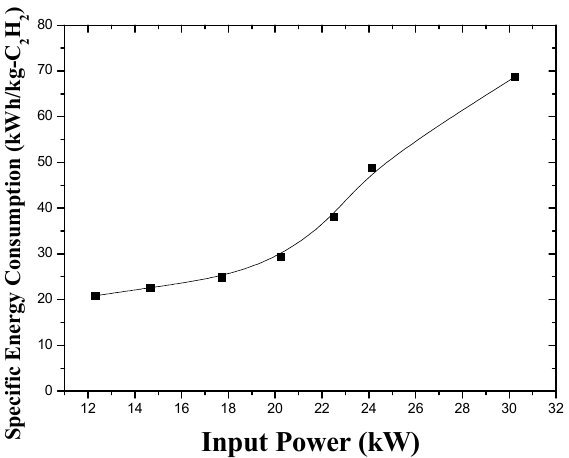
Figure 13. Variation in specific energy consumption of C 2 H 2 with varied input power (Carrier gas flow rate: 1 Nm 3 /h; working gas flow rate: 5 Nm 3 /h; feed rate: 17.65 g/min; magnetic flux intensity: 0.077 T).